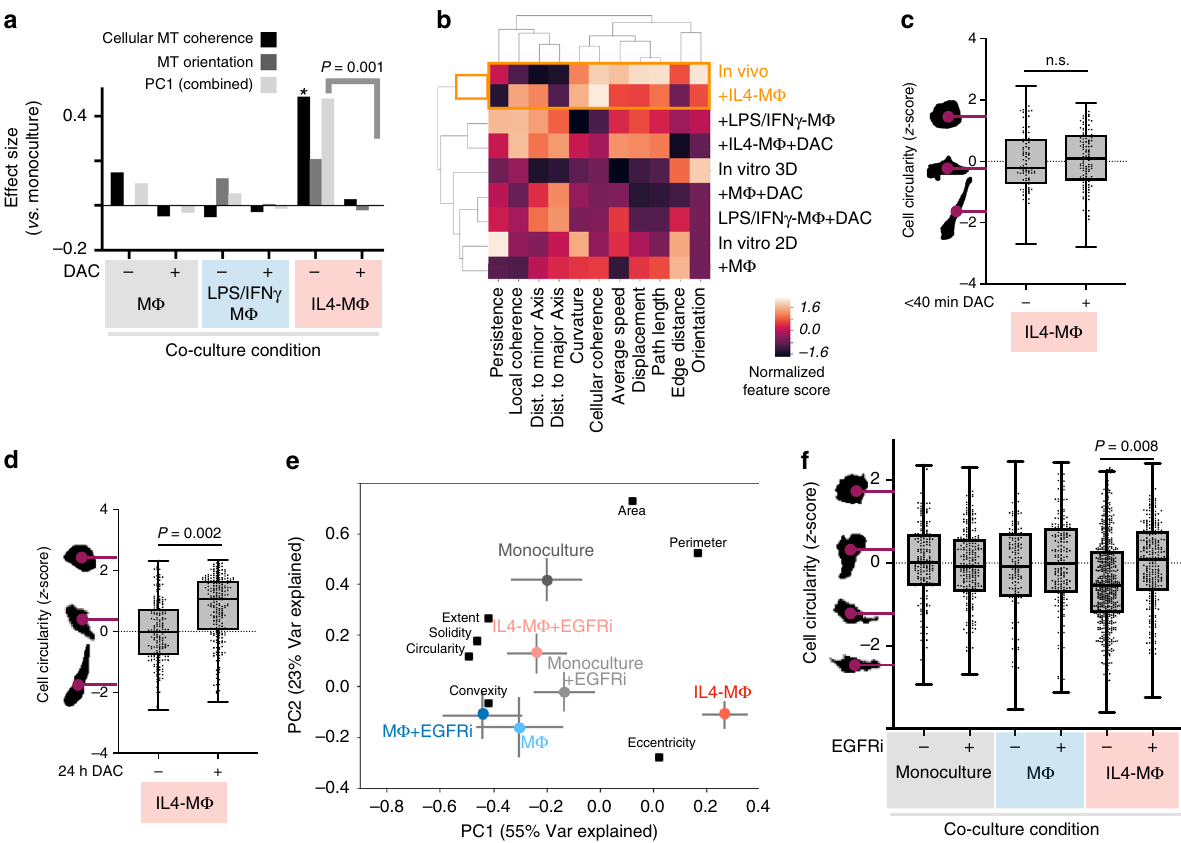
Fig. 8 Drug-induced changes in MT dynamics precede changes in overall cell shape. a After 24 h co-culture, HT1080 MT dynamics were imaged from 5 – 40 min following 10 μ M mTOR/pan-PI3K inhibitor dactolisib (DAC), and effect sizes were calculated as in Fig. 5a, b, comparing to untreated monoculture (*two-tailed permutation test; n = 12,524 tracks from n = 109 total cells). Corresponding to a , MT tracks were clustered according to average values ( b ), and tumor cell shape quanti fi ed following DAC at <40 min ( c ) or 24 h ( d ) post treatment (*two-tailed Mann – Whitney U test; c n = 223 cells, d n = 413 cells). e – f HT1080 were treated for 24 h with anti-EGFR mAb (EGFRi), quanti fi ed for cell shape, and analyzed by PCA ( e n = 1594 total cells; mean ± s.e.m.) and for cell circularity (*two-tailed t test; n = 1678 cells; bar denotes median). All box plots are min, 25%tile, median, 75%tile, and max. Source data are provided as a source data fi